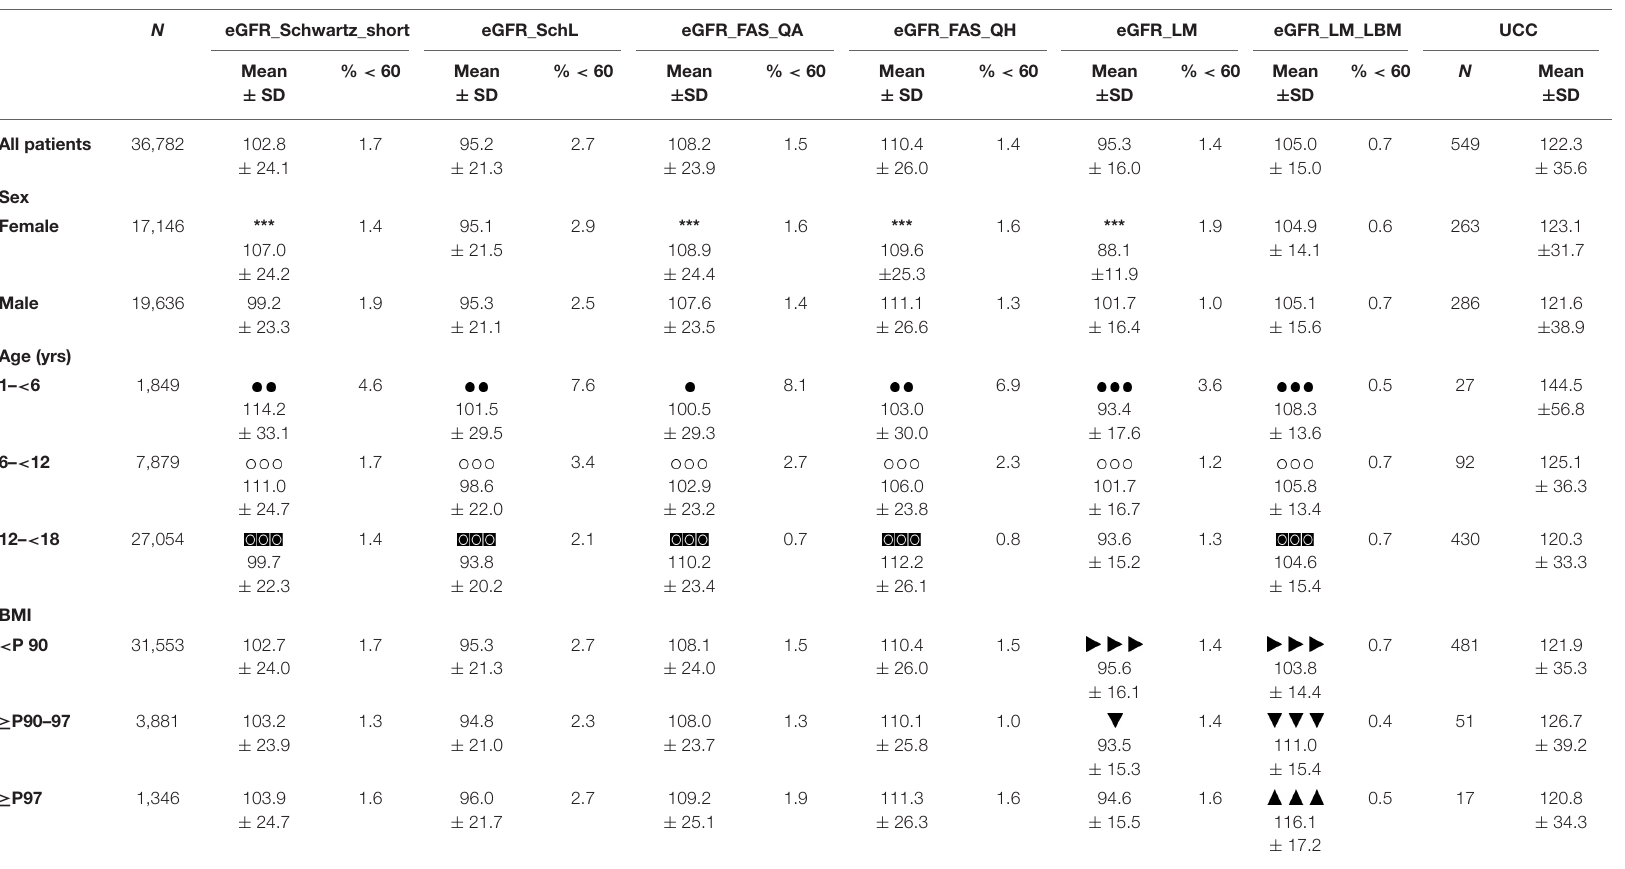
TABLE 2 | eGFR values (ml/min/1.73 m 2 ) and UCC in all patients and subgroups according to gender, age, and BMI as well as percentages of eGFR values < 60 ml/min/1.73 m 2 ; unadjusted comparison female to male group: *** p < 0.0001; unadjusted comparison age group 1– < 6 and age group 6– < 12: p <